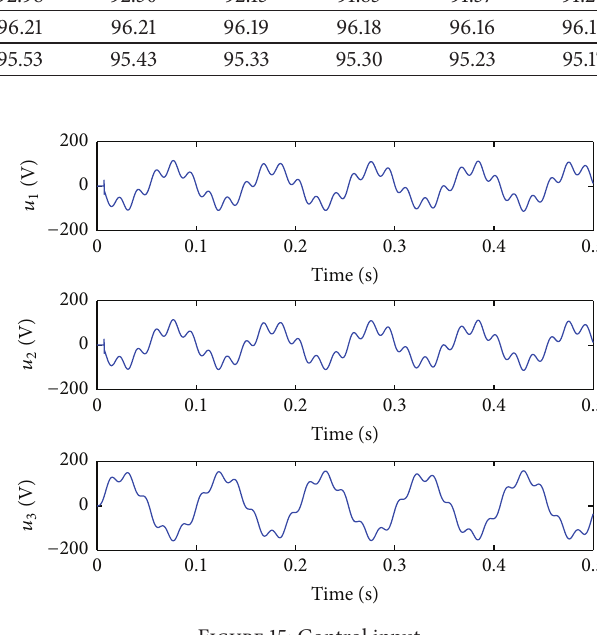
Figure 15: Control